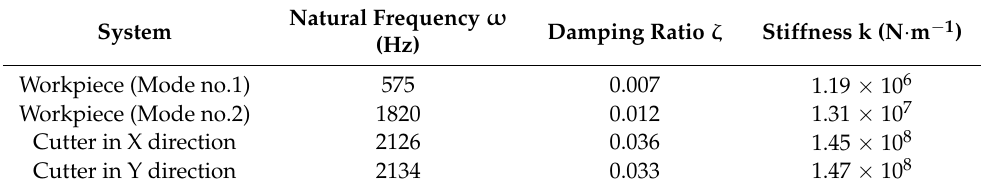
Figure 7. ( a ) Distributed points 1, 2, and 3 on the thin-walled plate for impact tests. ( b ) Position of the sensor and point 2 for measuring responses. ( c ) Position of the sensor and cutter region for machining. Table 2. Modal parameters of the cutter and workpiece.